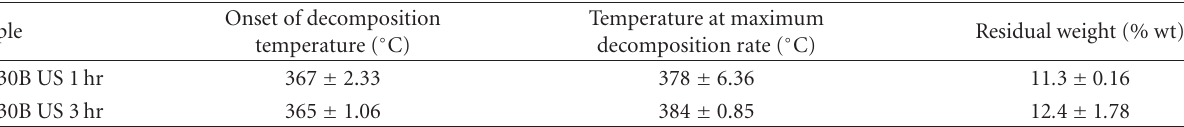
Table 2: The thermalgravimetric analysis on samples.